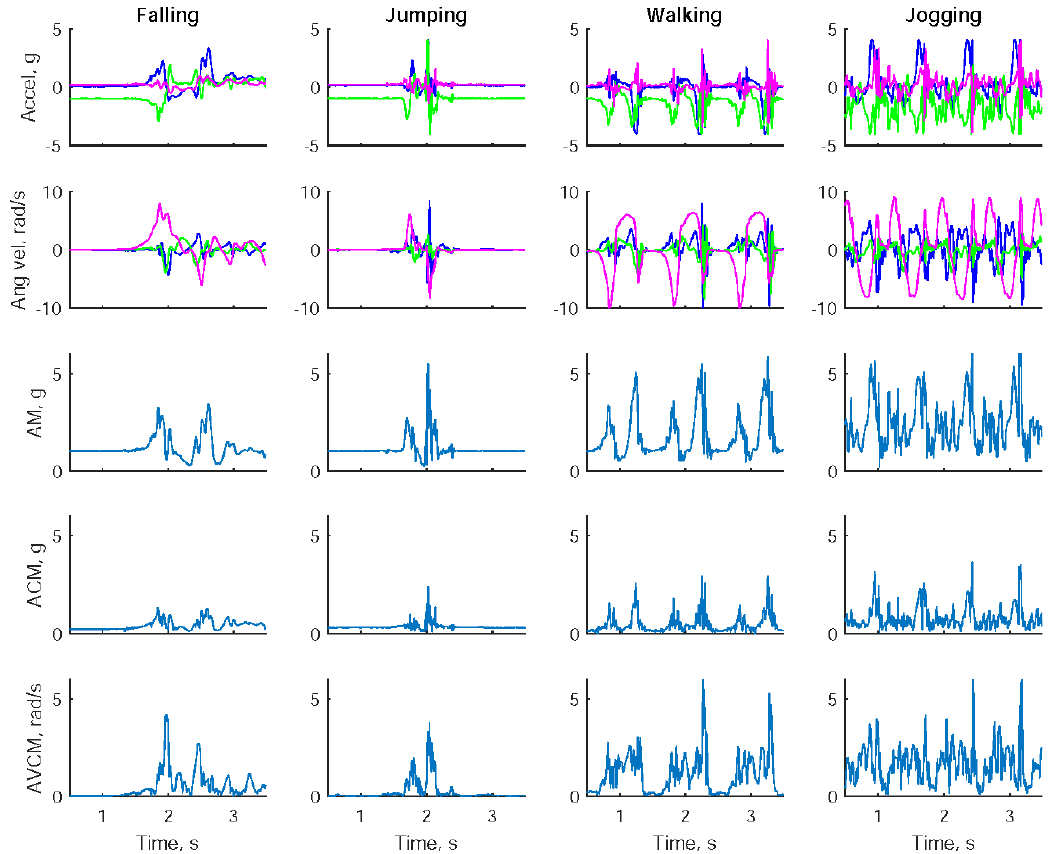
Figure 2. Tri-axial accelerations, tri-axial angular velocities, and the corresponding inertial parame- ters including acceleration amplitude (AM), acceleration cubic-product-root magnitude (ACM), and angular velocity cubic-product-root magnitude (AVCM) while a subject was undertaking a forward fall, a jump, a forward walk, and a forward jog.